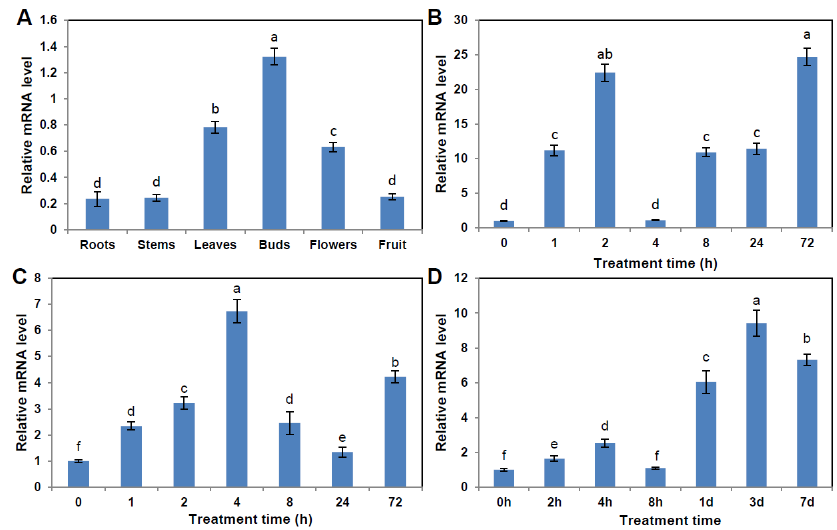
Figure 3. The gene expression analysis of CsICE1 in tea tree. Expression patterns of CsICE1 in different tissues ( A ), including roots, stems, leaves, buds, flowers, and fruit. Time course expression profiles of CsICE1 in response to cold ( B ), salt ( C ), and dehydration ( D ) stress. Samples were harvested at indicated time intervals. Error bars show the standard deviation based on four replicates. Different letters present a significant difference ( p < 0.05).